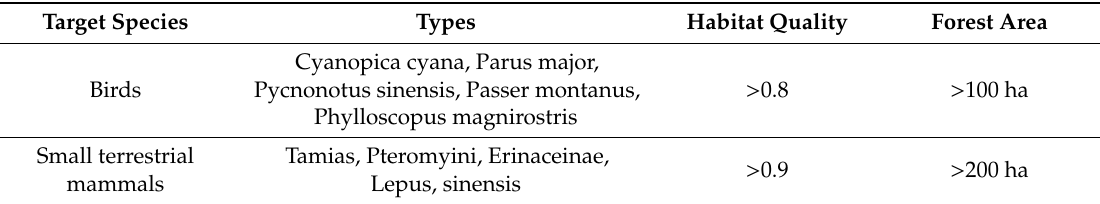
Table 2. Extraction indicators of source